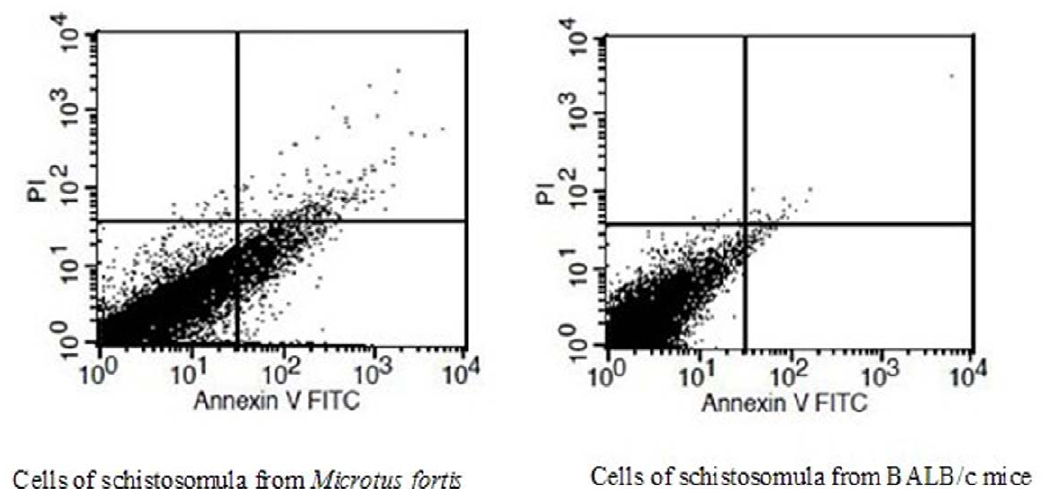
Figure 8. Apoptotic and necrotic cells of schistosomula taken from from BALB/c mice and Microtusfortis determined by Annexin V- FITC/PI analysis. The lower left quadrants refer to intact cells (AnnexinV 2 PI 2 ); the lower right quadrants show early apoptotic cells (AnnexinV + PI 2 ); the upper right quadrants refer to late apoptotic and/or necrotic cells (AnnexinV + PI + ). The figures are representative of three independent experiments.